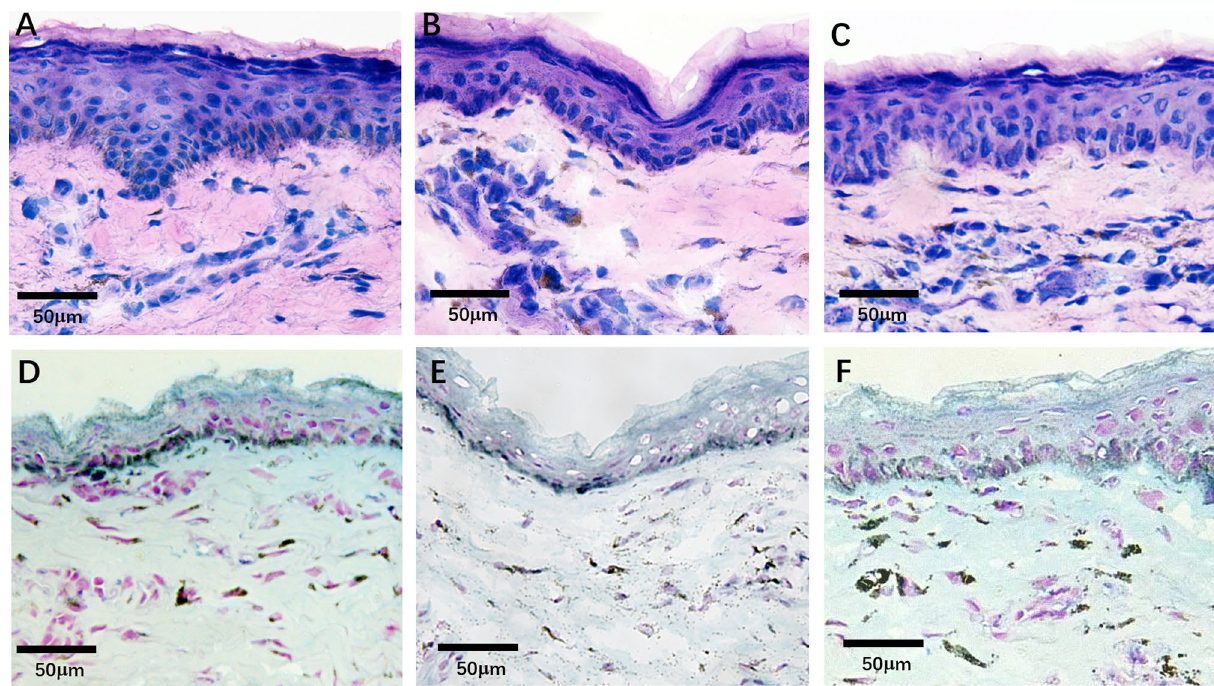
Figure 2. HE and FeSO4 staining images in different types of dark circles. ( A ) HE staining of normal skin. ( B ) HE staining of skins with vascular type of dark circles. ( C ) HE staining of skins with pigmented type of dark circles. ( D ) FeSO4 staining of normal skin. ( E ) FeSO4 staining of skins with vascular type of dark circles. ( F ) FeSO4 staining of skins with pigmented type of dark